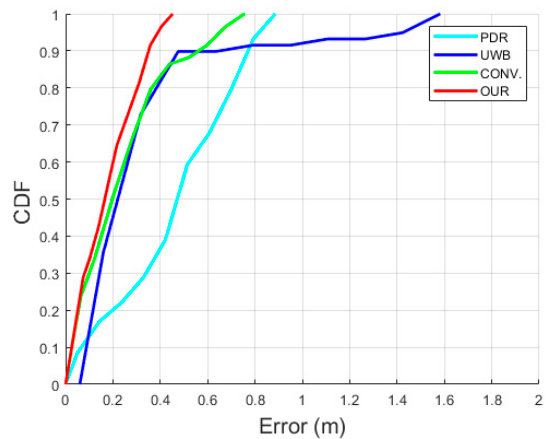
Figure 13. CDF of positioning errors in single-lap NLOS scenario.